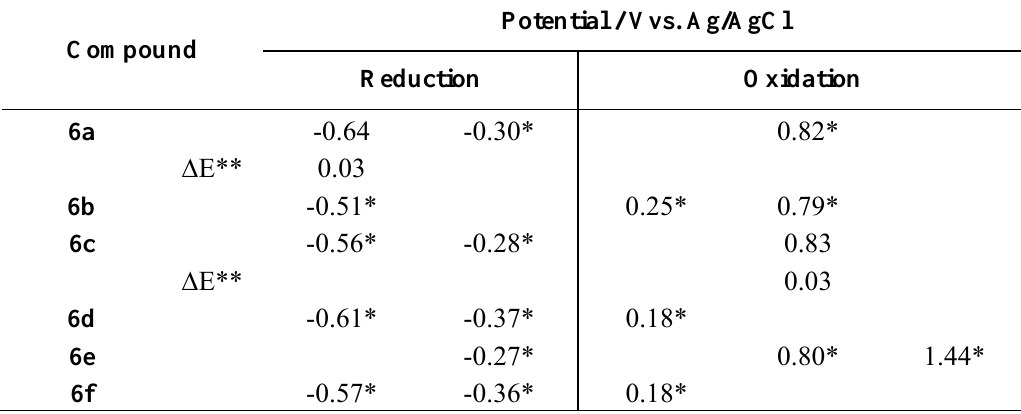
Table 8. Reduction and reduction potentials of 6